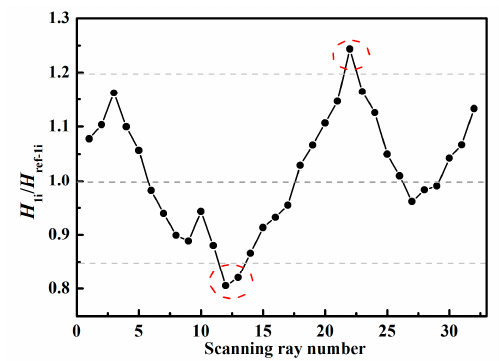
Figure 13. Ratio curve of the ray paths to the bottom-left corner for the front side.